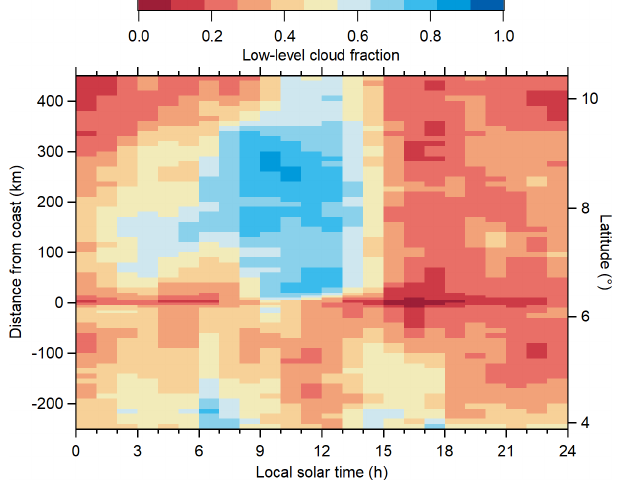
Figure 2. The diurnal cycle of mean low-level cloud fraction at dif- ferent distances inland or offshore over Togo and Benin (4–11 ◦ N, 0.6–2.75 ◦ E), taken from the LLC flag derived from SEVIRI cloud data. The data are shown from the time period coinciding with the DACCIWA aircraft campaign: 29 June–16 July 2016. The latitude scale on the right axis is approximate, as the latitude of the coastline varies by 0.6 ◦ over Togo and